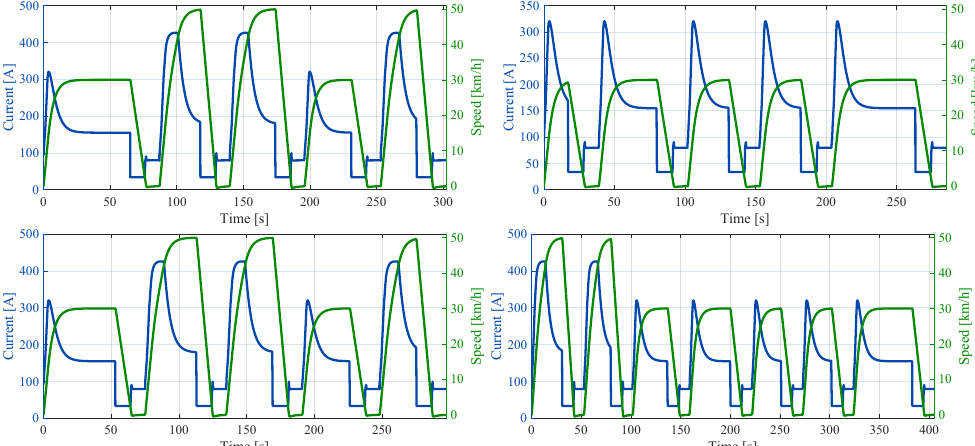
Figure 7. Traction diagram speed (green traces) and currents (blue traces) of IMC trolleybuses covering the paths of line 14 (upper figures) and line 15 (bottom figures). Outward journeys are on the left side; return journeys on the right